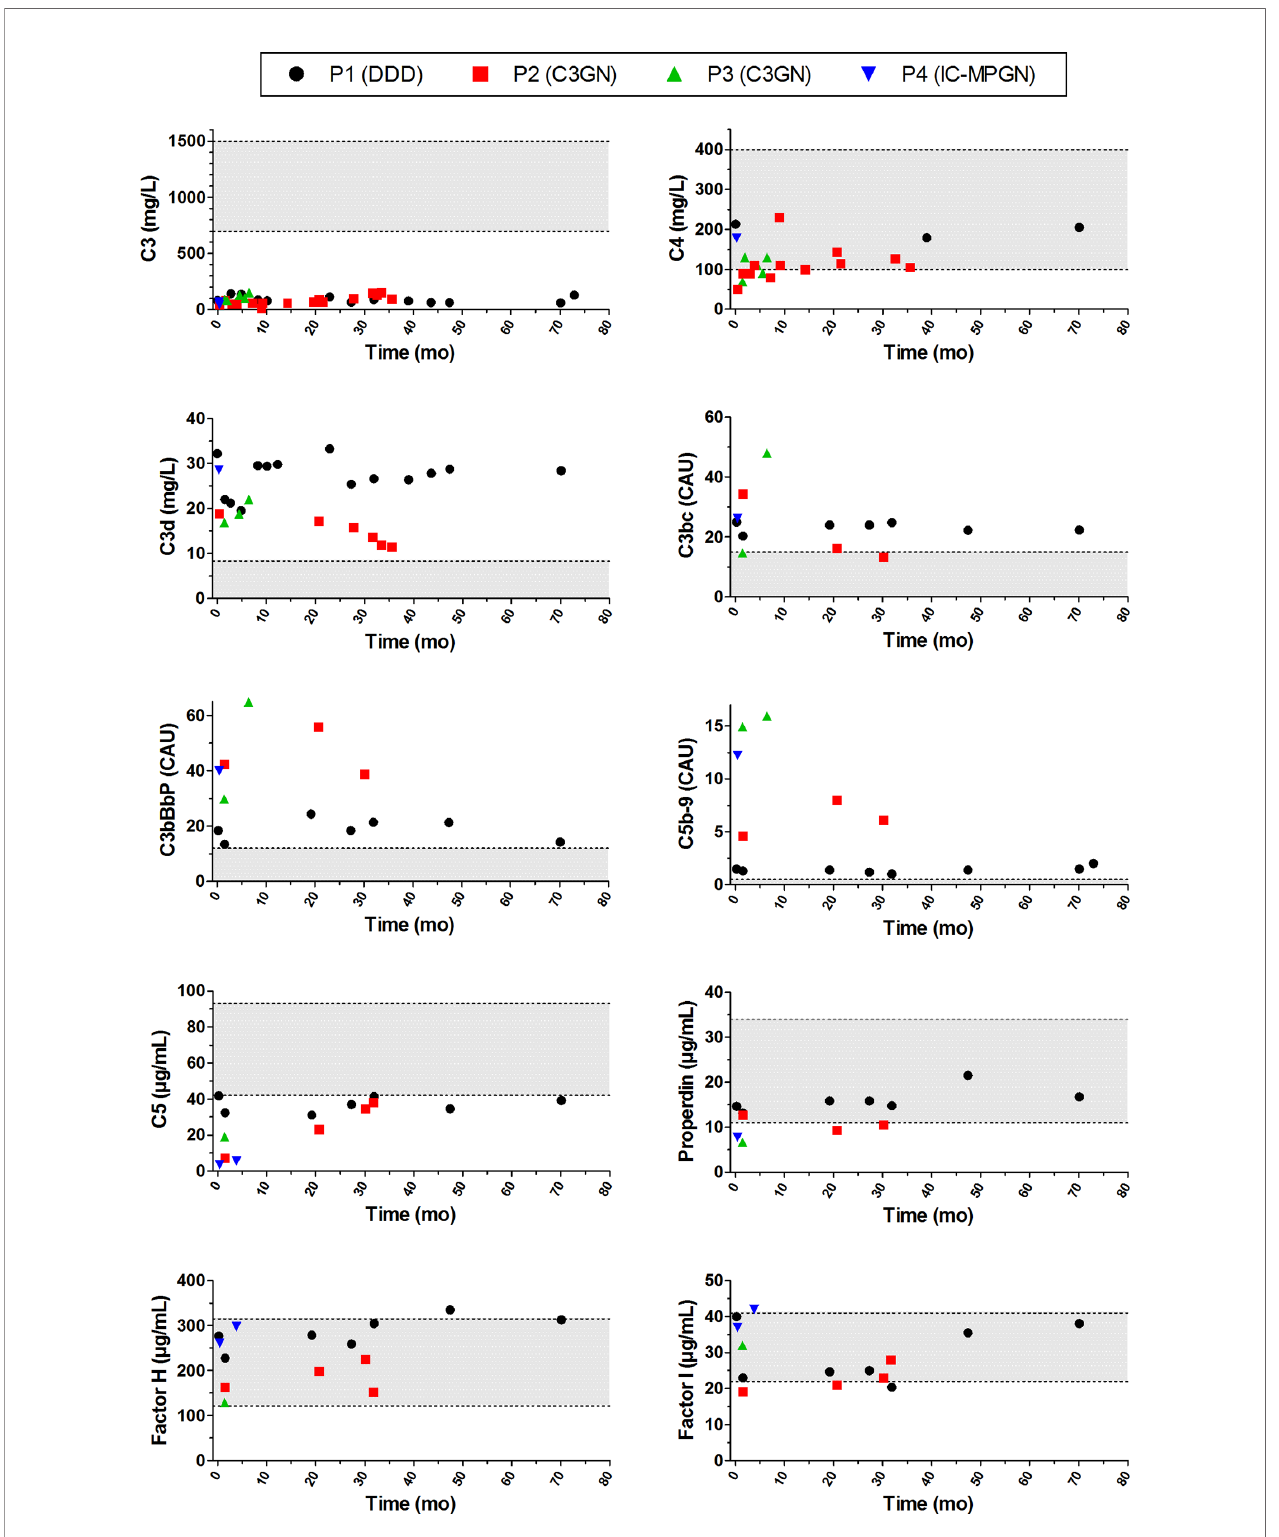
FIGURE 8 | Complement activation pro fi les of the patients with prolonged classical pathway convertase activity during follow-up. Follow-up is indicated as time after initial presentation in months (mo). Grey areas indicate the healthy control ranges. DDD, dense deposit disease; C3GN, C3 glomerulonephritis; IC-MPGN, immune complex-mediated membranoproliferative glomerulonephritis; CAU, complement arbitrary